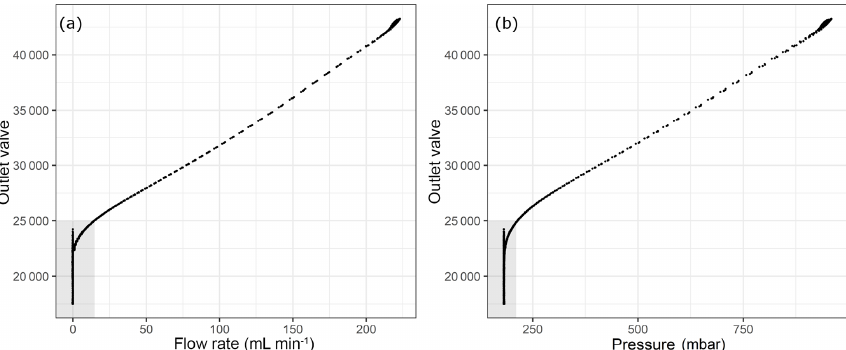
Figure 4. Flow parameters into the analyzer with respect to the internal parameter outlet valve (a) flow rate and (b) pressure at the outlet of the pressure regulator. Shaded areas correspond to the depletion of sample